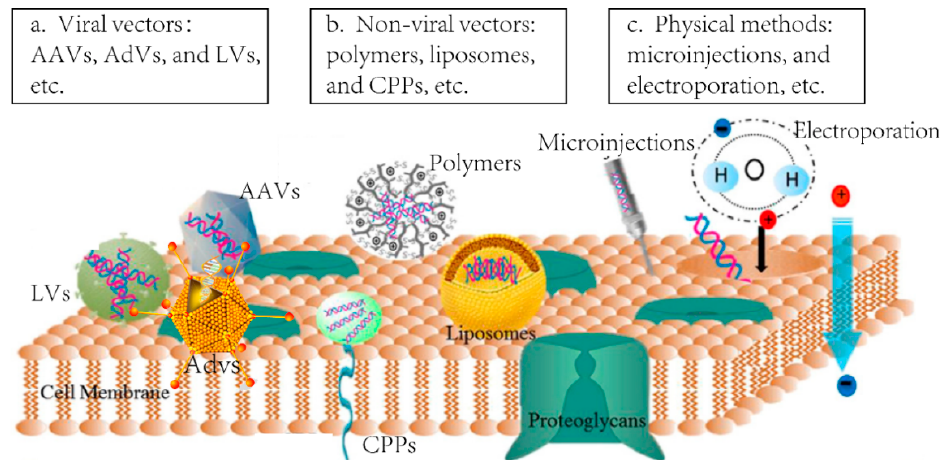
Figure 2. Current techniques used for gene delivery. ( a ) Viral vectors containing adeno-associated virus vectors (AAVs), adenovirus vectors (AdVs), and lentivirus vectors (LVs), etc. ; ( b ) non-viral vectors containing polymers (e.g., polyethylenimine—PEI, poly(L-lysine)—PLL), liposomes (e.g., 1,2-dioleoyl-3-trimethylammonium-propane—DOTAP, cholesterol), and cell-penetrating peptides (CPPs), etc. ; and ( c ) physical methods containing microinjections, and electroporation, etc. , from reference [16].